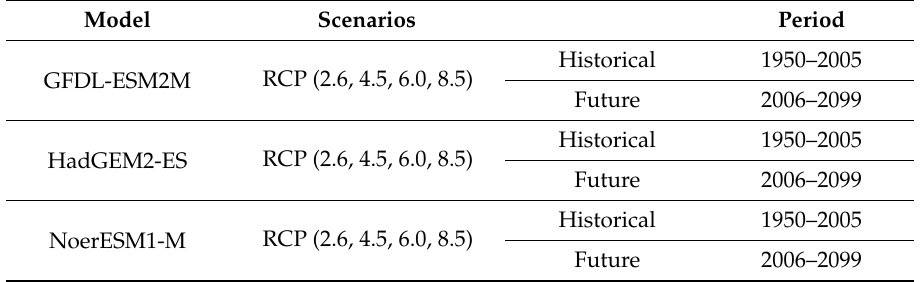
Table 7. Global Circulation Models with Representative Concentration Pathways (RCPs) and periods.